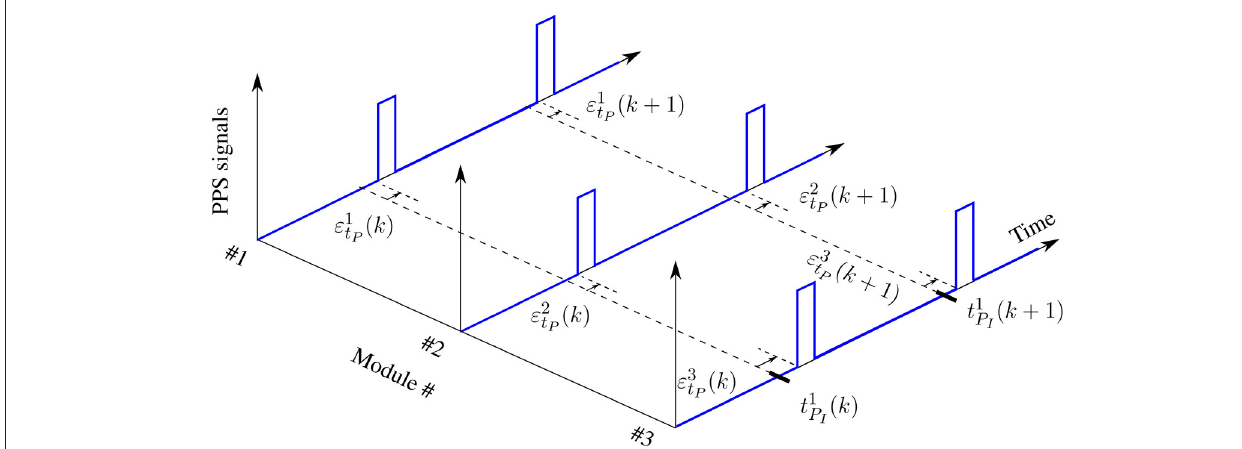
FIGURE 10 | Errors of PPS signals in multiple GPS modules.